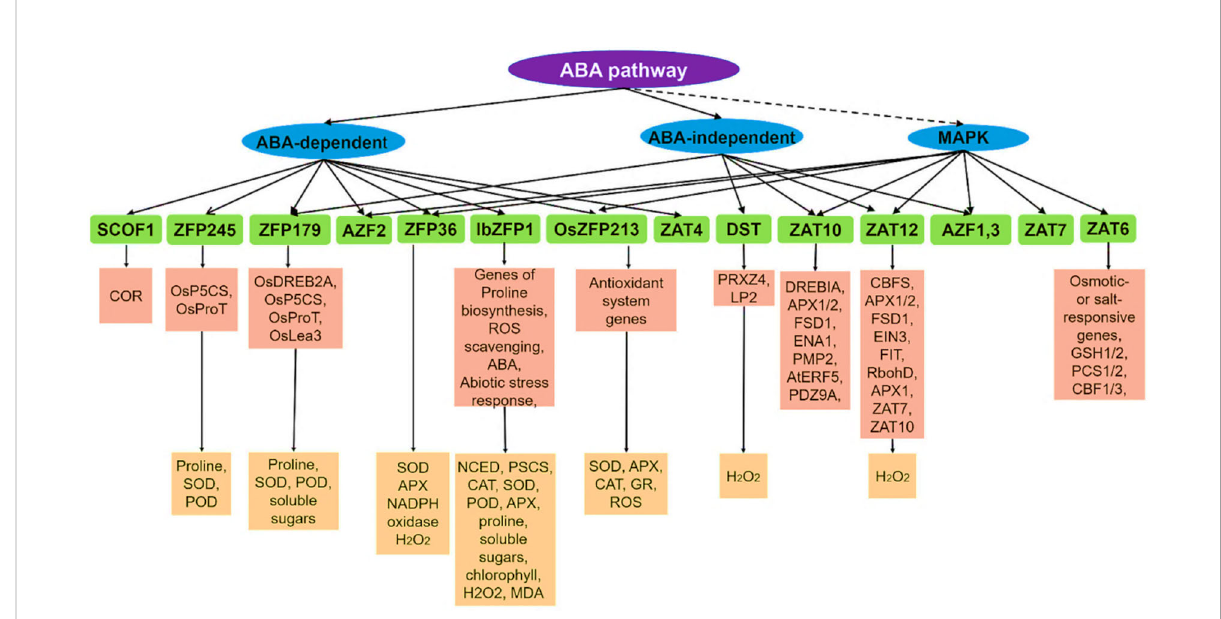
FIGURE 3 The signalling pathways of zinc fi nger proteins during abiotic stress response in plants. Note: The lines marked as solid indicate regulation, and the dashed lines indicate putatively. The C2H2 zinc fi nger proteins are SCOF-1, ZFP245, ZFP179, AZF1/2/3, ZFP36, IbZFP1, OsZFP213, ZAT4, DST, ZAT10/STZ, ZAT12, ZAT7 and ZAT6. Source: (Liu et al.,